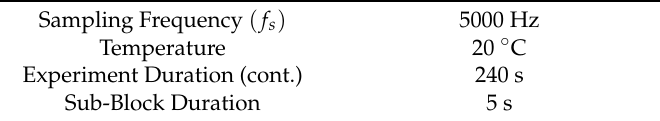
Table 6. Relevant parameters for the cavitating experiments.